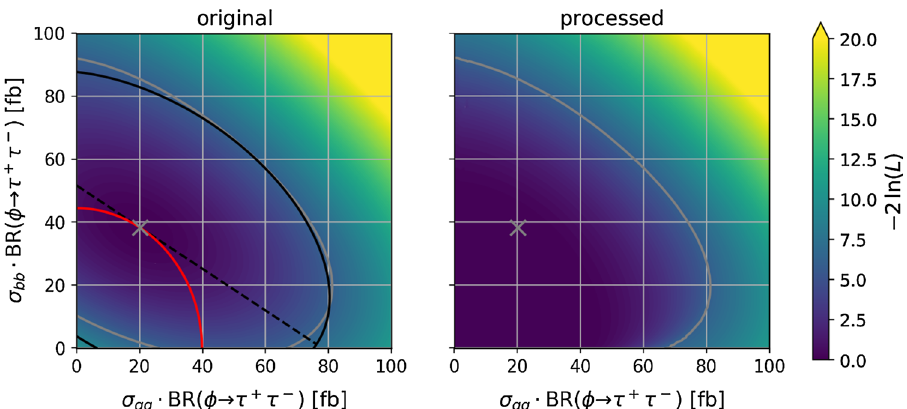
HiggsBounds . The 95% C.L. contour and best fit point are indicated in grey. The black ellipse with the corresponding long axis (dashed) and the red ellipse shown in the left panel are used in the construction of the processed likelihood (see